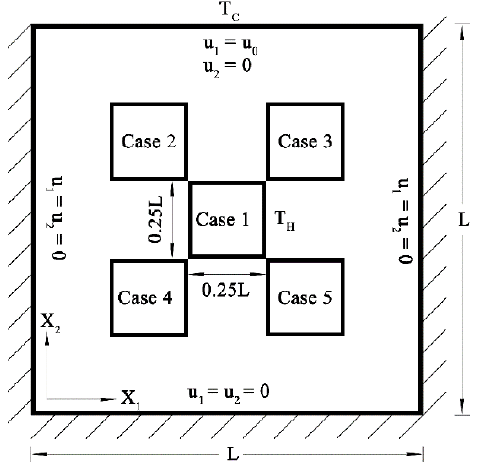
Figure 1. Schematic diagram of the enclosure with different positions of the